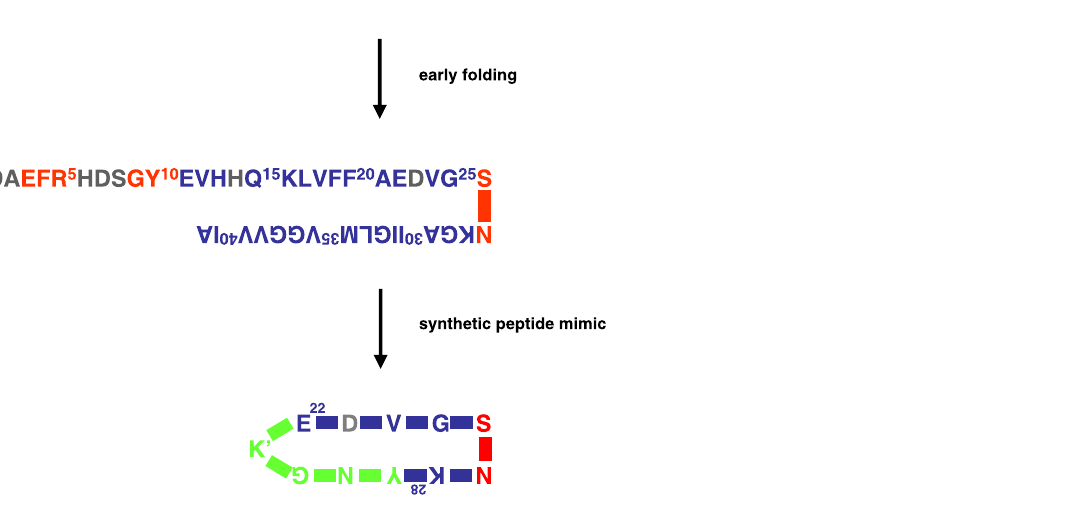
Figure 1. Early folding of human amyloid b (A b ), around S26 and N27. The figure is a simplification of the model designed by Olofsson et al. [28]. Residues in red are solvent accessible; residues in blue (and to a lesser extent in gray) are shielded from the solvent. The peptide cyclo[A b (22– 28)-YNGK 9 ] is a mimic for misfolded A b . YNGK 9 is a turn-stabilizing sequence and K 9 is a side-chain-modified lysyl residue for selective conjugation to a protein carrier. Other YNGK 9 -containing cyclic peptides prepared (23–28, 24–29, 25–30, 21–27, 22–28, 23–29, 24–30, and 25–31) did not mimic misfolded A b .